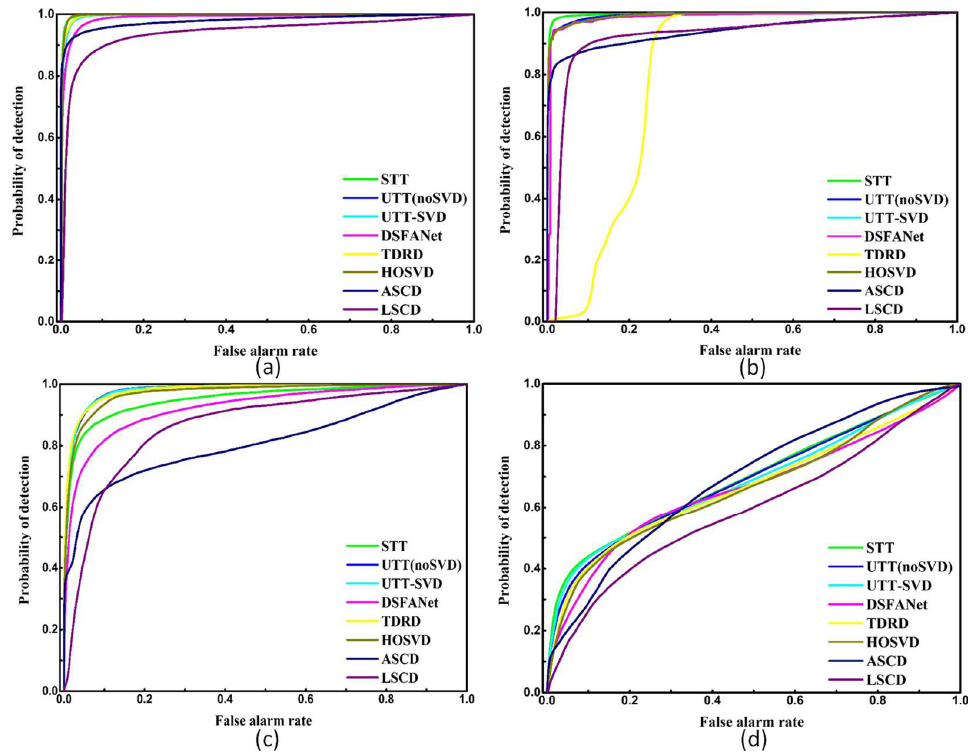
Table 2. Evaluation of AUC values for different methods.